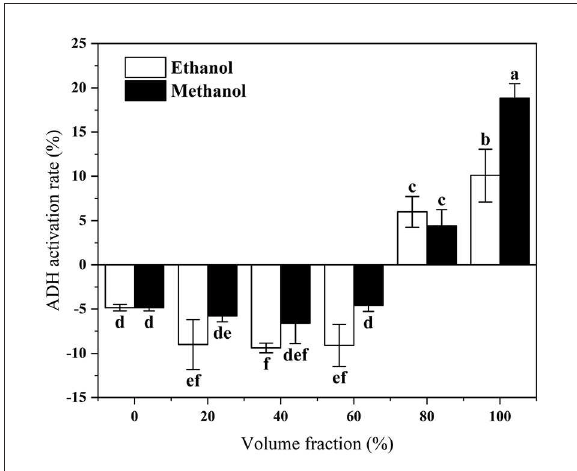
FIGURE1 In vitro activation of ADH by lotus root extracts with different volume of fraction solvents. Different letters represent significant differences between